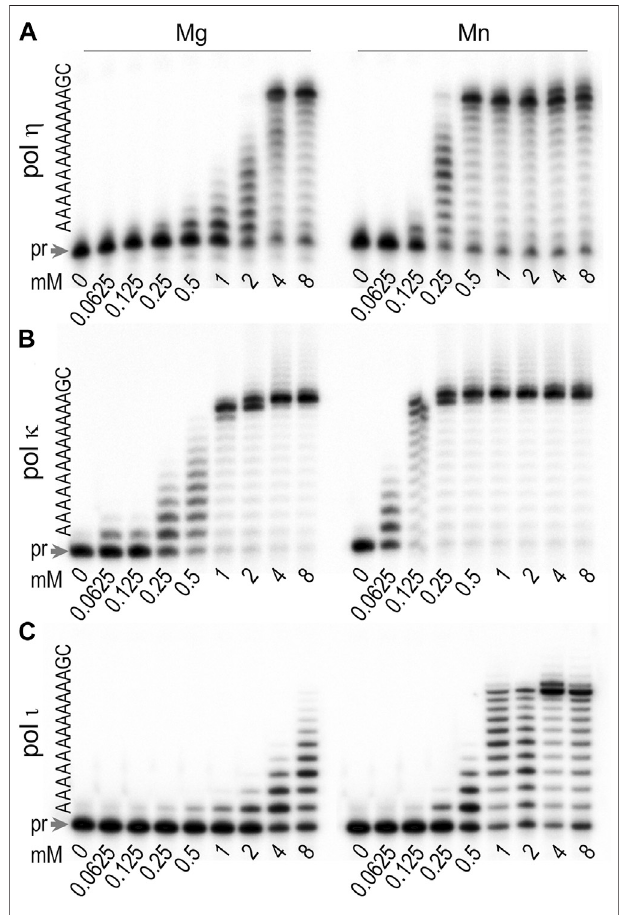
FIGURE 3 | Determination of metal ion requirements (type and concentration) for optimal activity of (A) pol η (B) pol κ , and (C) pol ι . The extension of 32 P-labeled primer 5 ′ -CGATGGTACGGACGTGCTT-3 ′ hybridized to a template 3 ′ -GCTACCATGCCTGCACGAAAAAAAAAA AAGC-5 ′ wascarriedoutfor10 minat37 ° Cinthepresenceof100 μ MdNTPs mixture and with increasing concentrations of MgCl 2 or MnCl 2, ranging from 0.0625 to8 mM. Concentrations ofenzymes were 0.17 pM for pol η , 0.32 pM for pol κ , and 0.15 pM for pol ι . The sequence of the template immediately downstream of the primer (pr) is shown on the left-hand side of each gel pair.